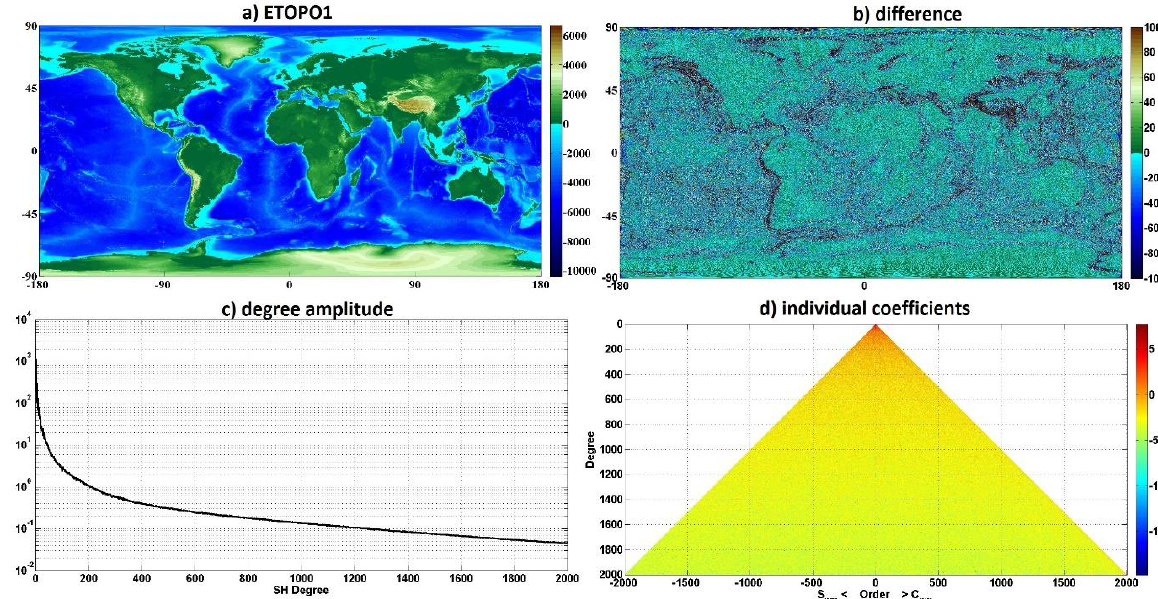
Figure 2. a) ETOPO1 global relief model in m, b) difference between the original ETOPO1 and synthesized model from estimated